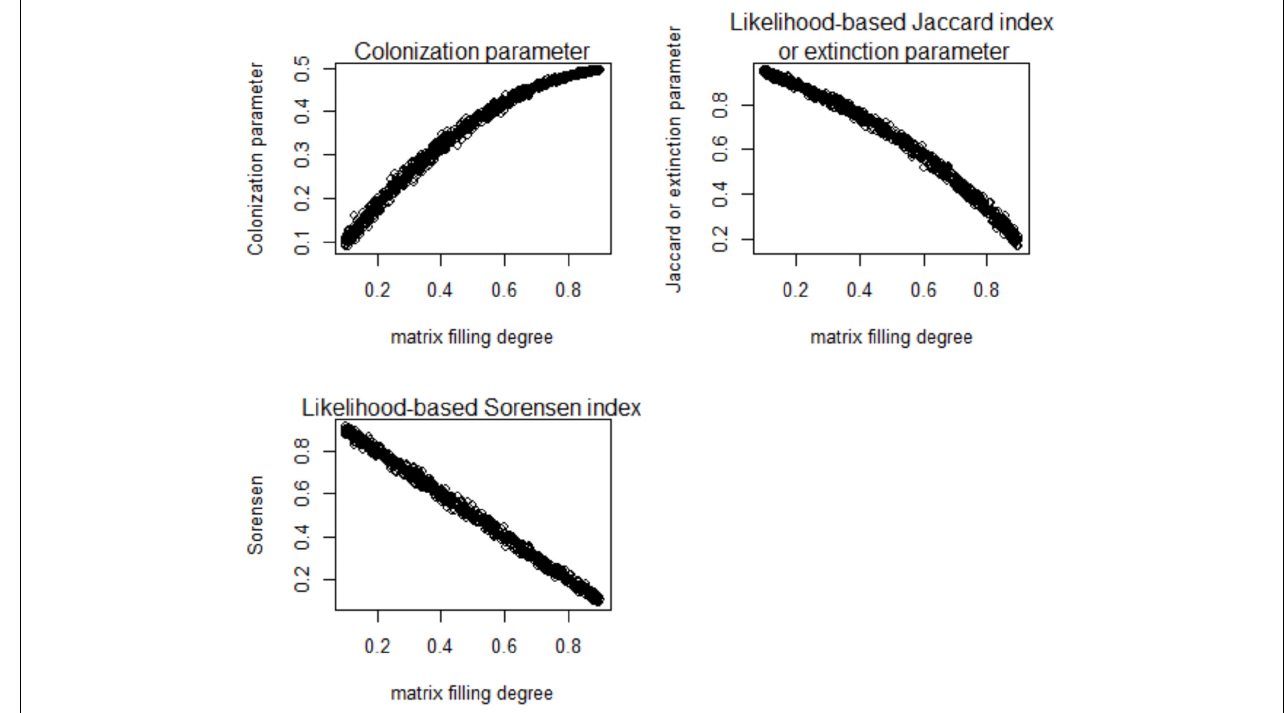
FIGURE 2 | Relationships of the colonization rate and extinction rate with multi-site beta diversity indices inferred using the proposed likelihood model and matrix filling degree ( p ) in a numerical simulation.